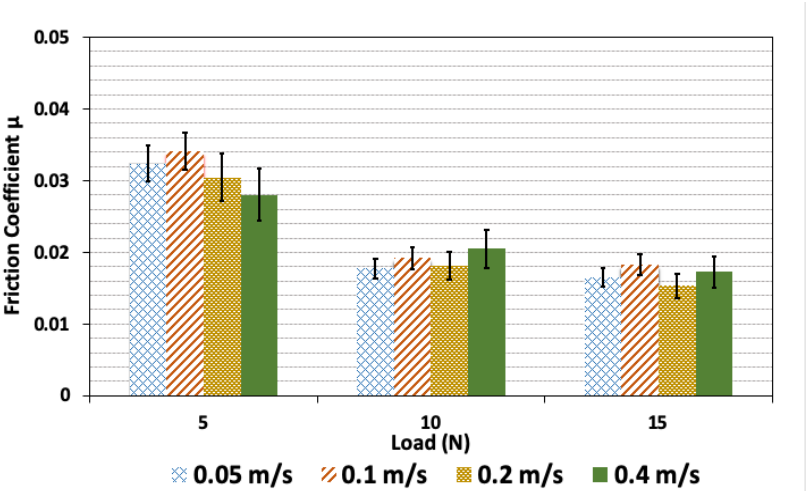
Figure 7. Friction coefficient of PVA/GG hydrogel with 0.1 wt% GG for different sliding velocities of 0.05, 0.1, 0.2 and 0.4 m/s. The results are shown for three different loads of 5, 10, and 15 N.